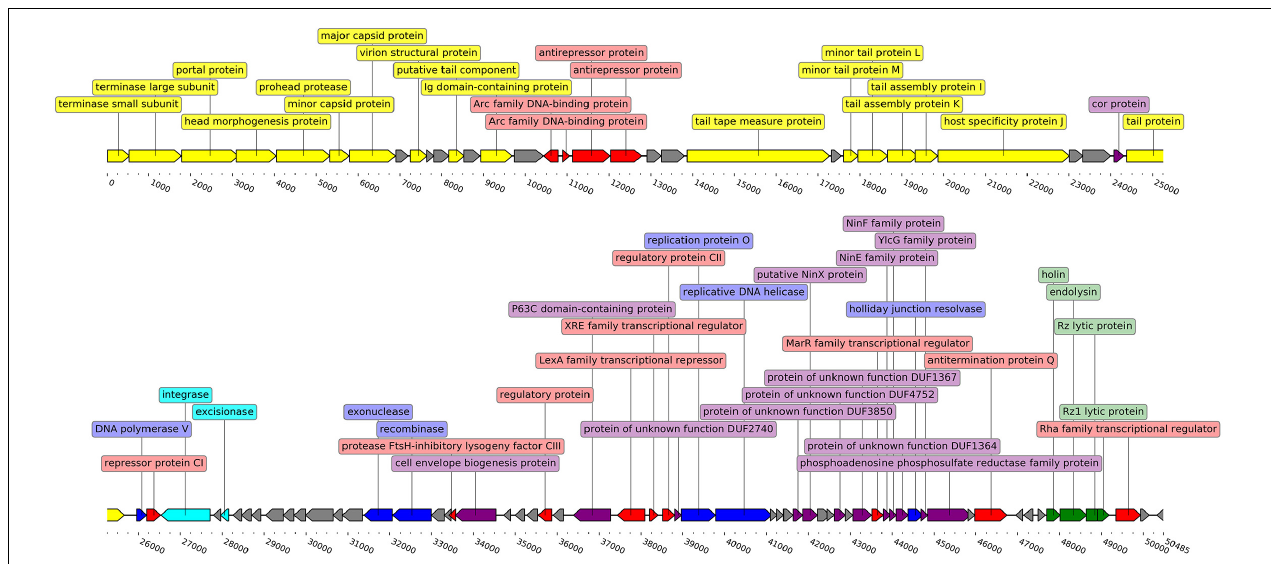
FIGURE 2 | Linearized genome map of phage Midgardsormr38. Black line represents the genome itself. Arrows represent ORFs and show the direction of transcription. Colors are indicative of the predicted functions of respective ORF gene products. Yellow color was assigned to ORFs responsible for phage particle morphogenesis, green—lysis, red—transcription, blue—DNA replication, modification and repair, cyan—lysogeny, purple—additional functions, gray—ORFs encoding proteins with functions unknown. Labels show the putative functions of gene products. The genome map was created using the DNA features viewer (Zulkower and Rosser,